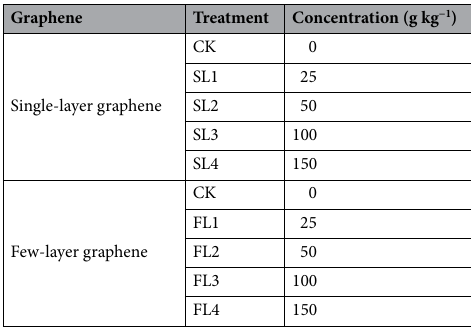
Table 1. Experimental